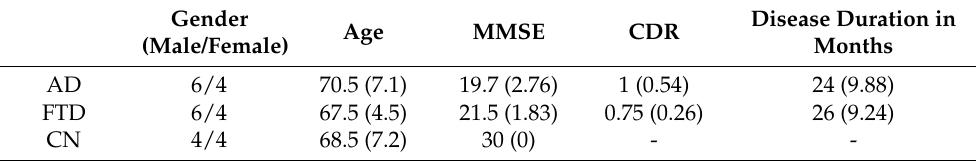
Table 1. Database statistical analysis (values in brackets represent standard deviation). The group of patients with Alzheimer’s disease is marked with AD while the group of patients with frontotemporal dementia is marked with FTD. Healthy, age-matched subjects formed the control group (CN). Disease Duration Gender CDR (Male/Female)